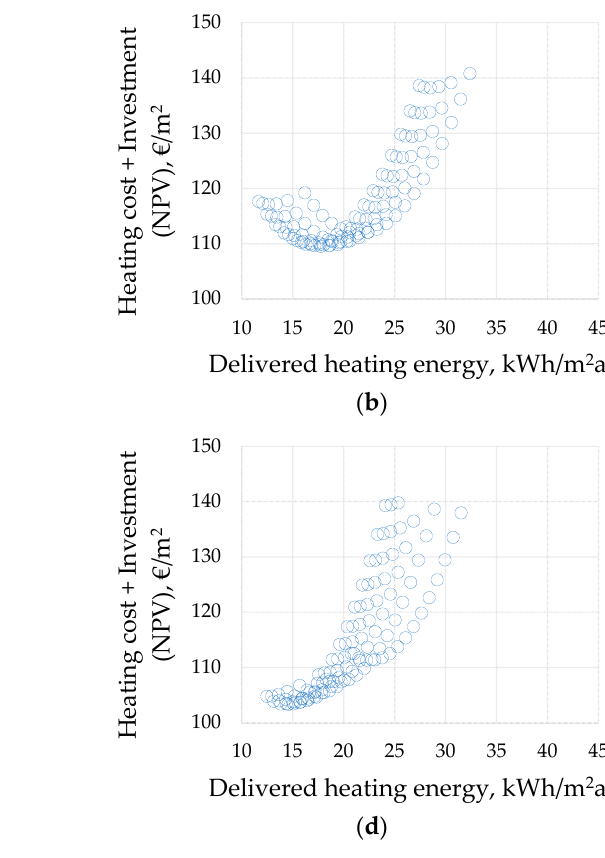
Figure 6. Cost optimal solution of a single floor model based on heating energy-related cost and investment cost in different climates ( a ) Tallinn, ( b ) Sapporo, ( c ) Paris, and ( d ) Brussels.